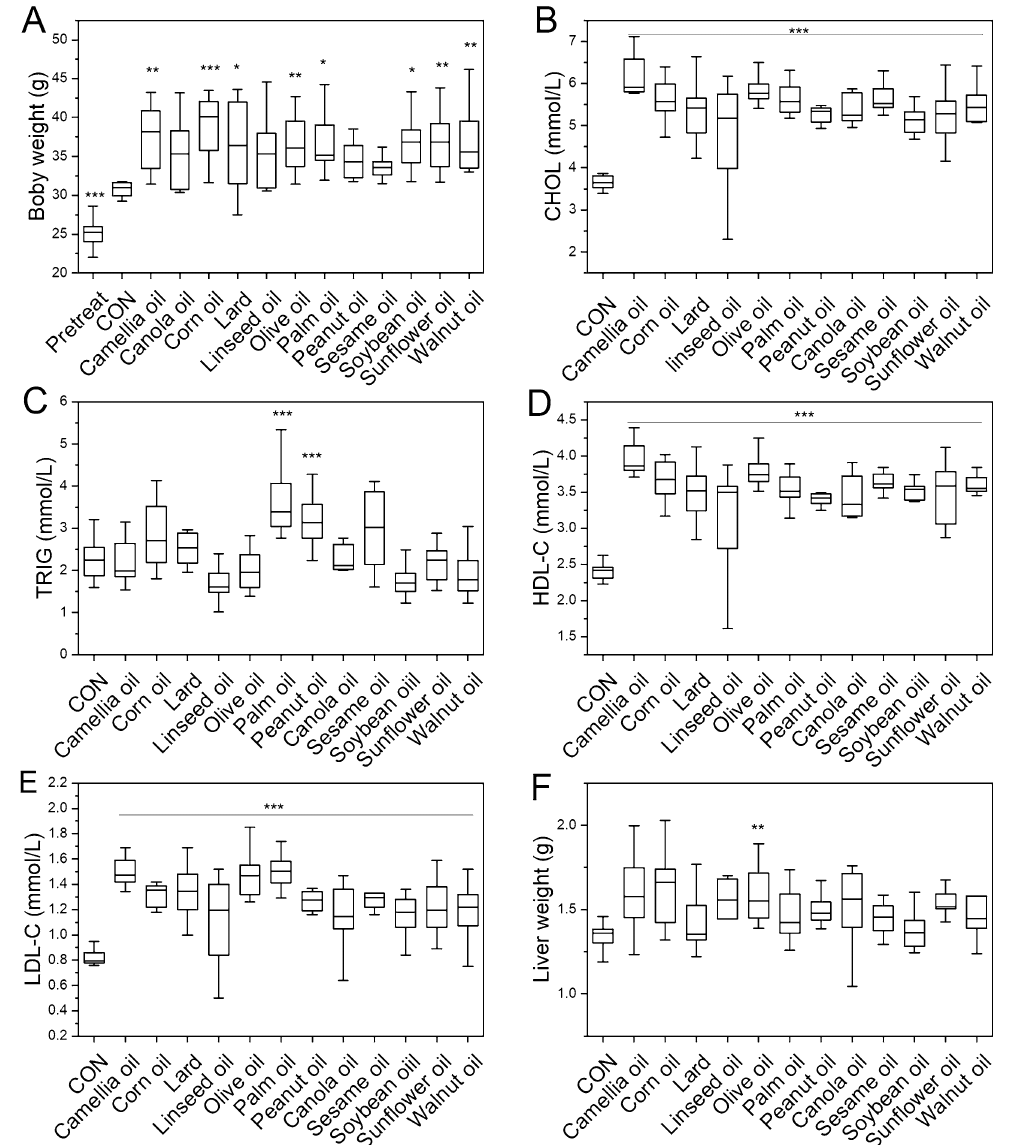
Figure 1. The effects of dietary oil on the body/liver weight and cholesterols of mice. Pretreat, the body weight of mice before intervention at 8 weeks old, and the other groups were measured after 8 weeks oil intervention. All oil intervention groups are compared with the control group. *p < 0.05; **p < 0.01; ***p <